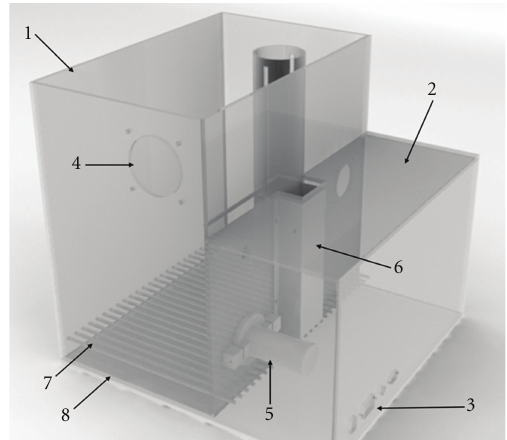
Figure 1: External view of the equipment. 1: acrylic structure; 2: rear panel; 3: power and interface plugins; 4: fan; 5: nose poke; 6: